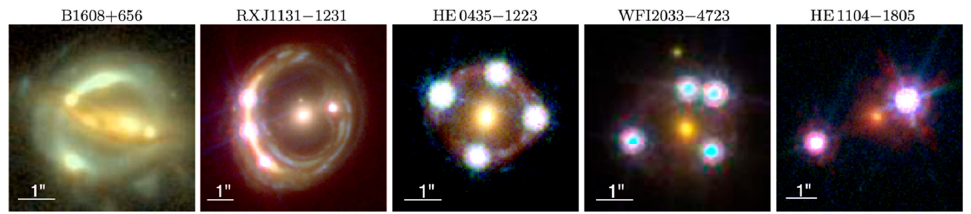
Figure 21. Multicolor images of the four quadruply lensed quasar systems in various configurations and one doubly lensed quasar system. The lens name is indicated above each panel from the H0liCOW collaboration; figure taken from [120]. Strong gravitational lens systems with time delays between the multiple images allow measurements of time-delay distances, which are primarily sensitive to the Hubble constant. They calculated that the Universe is actually expanding faster than expected on the basis of our cosmological